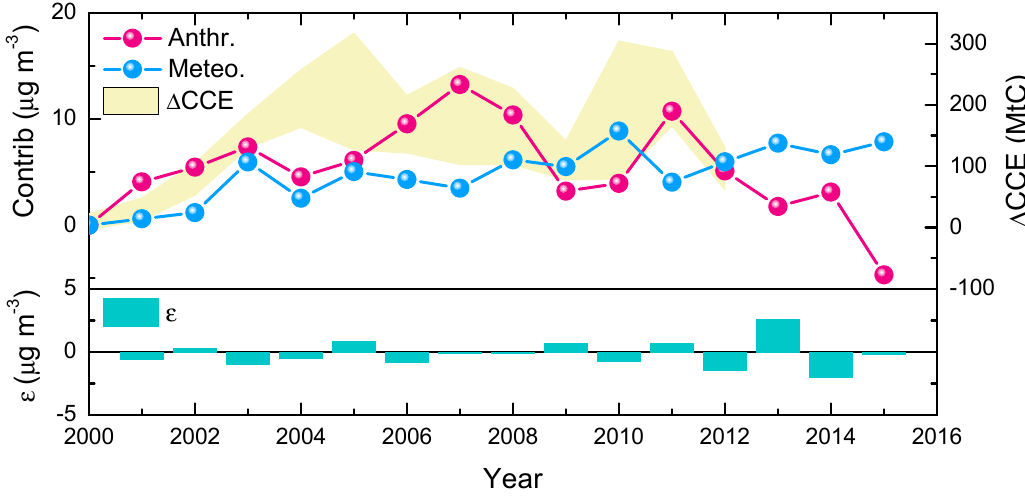
Figure 9. Year-by-year contributions to PM 2.5 variations ( Δ PM 2.5 ) from anthropogenic and meteorological factors averaged over all five polluted regions shown in Figure 1, for the period 2000–2015. ε is the residual. The shadowed area represents the variation range of China’s carbon emission ( Δ CCE) interannual changes derived from 24 emission inventories of fossil fuel combustion as reported in Liu et al. (2015) [51].